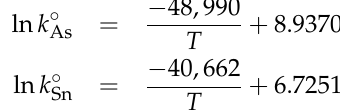
Figure 11b. Surface areas of the liquid bath except for the impact zone ( A LB ) and of the ejected droplets ( A ED ) are also shown in the